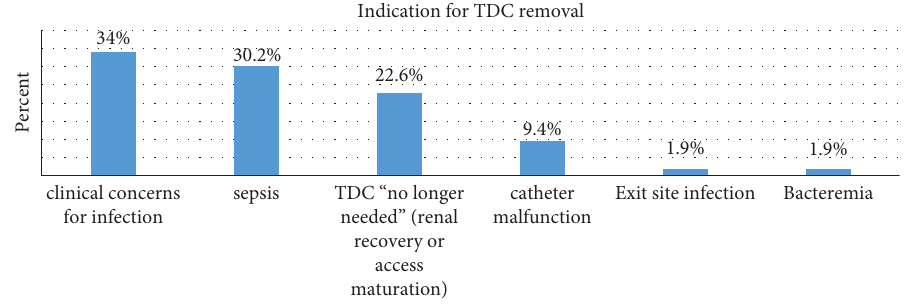
Figure 1: Percent distribution of the reasons for tunnelled hemodialysis catheter removal. Table 3: Relationship between the tunnelled hemodialysis catheter removal procedure and patients’ demographics, lab results, and underlying medical